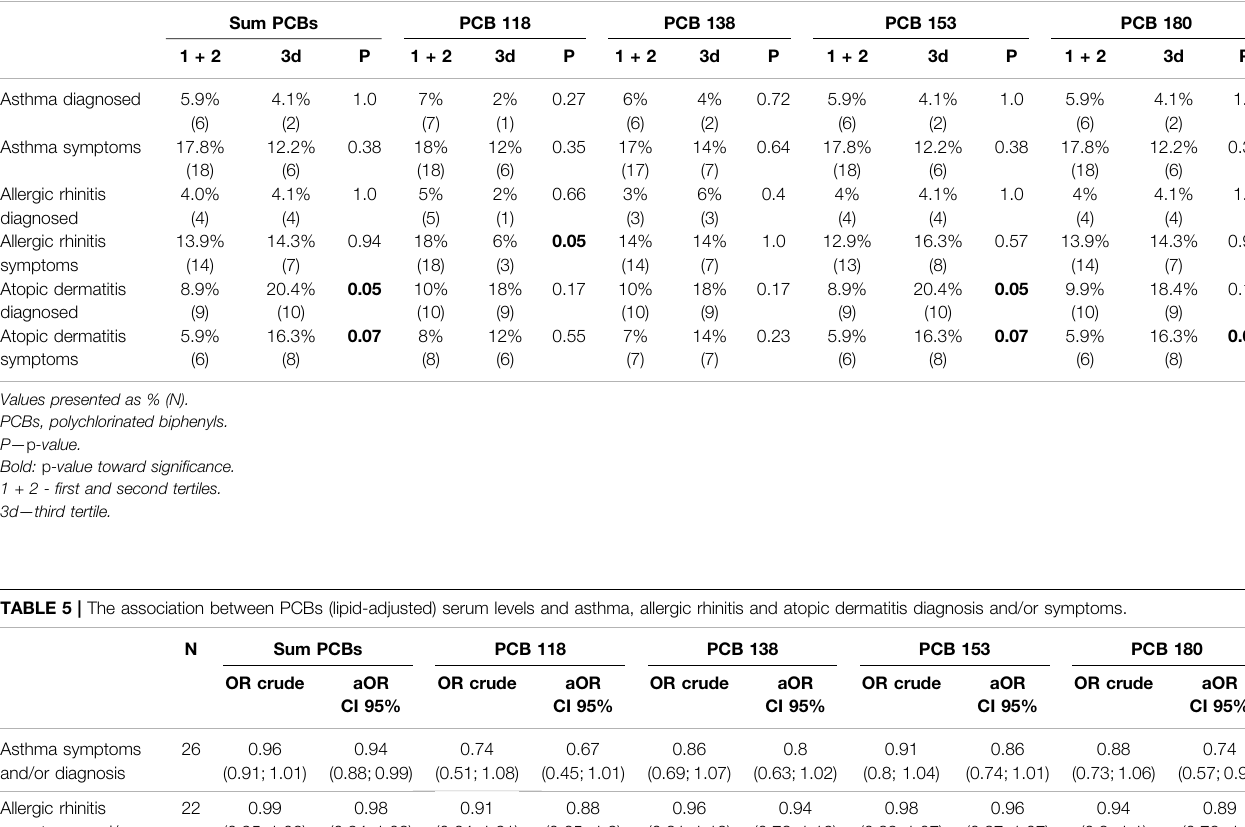
TABLE 4 | Comparison of number of children with allergic conditions, between fi rst + second tertiles vs. third tertile of maternal lipid adjusted PCBs serum concentration.